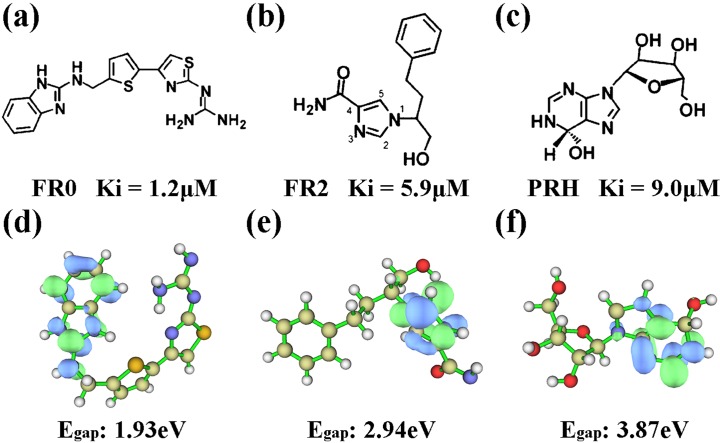
Chemical structures and LUMO orbits of the three ligands: FR0, FR2, and PRH.Ki and Egap of the three ligands are annotated.